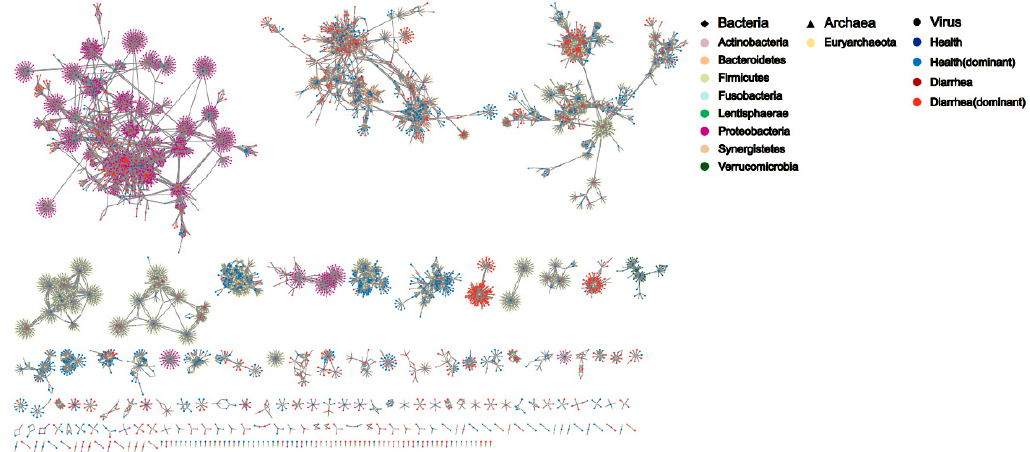
Figure 2. Bacteria–virus interaction network. The shape of the node represents different host taxonomy. The color within each kingdom category represents different taxonomy. Lines mean that a speci fi c host was infected by a virus.